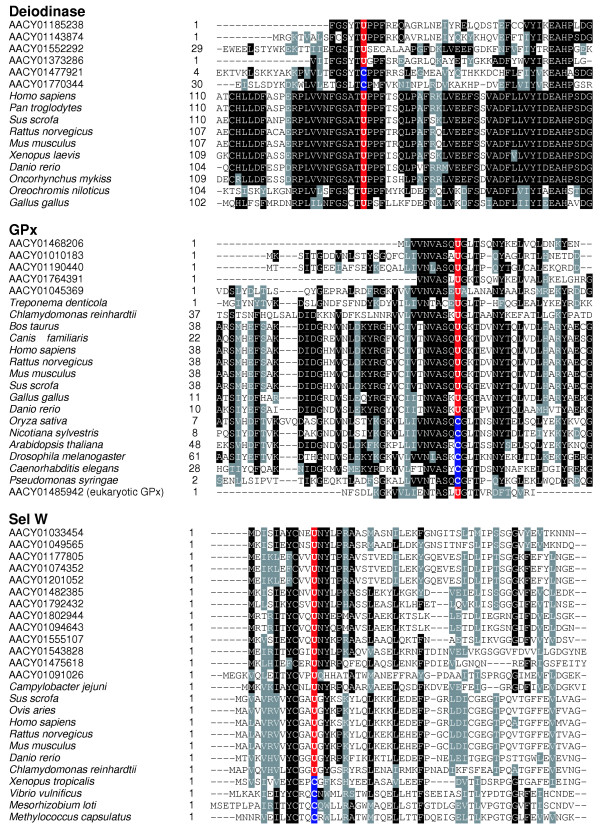
Multiple alignments of deiodinase, GPx and SelW. Conserved residues are highlighted. Predicted Sec (U) in selenoproteins and the corresponding Cys (C) residues in homologs are shown in red and blue background, respectively. Sequence alignments were generated with ClustalW and shaded by BoxShade v3.21.